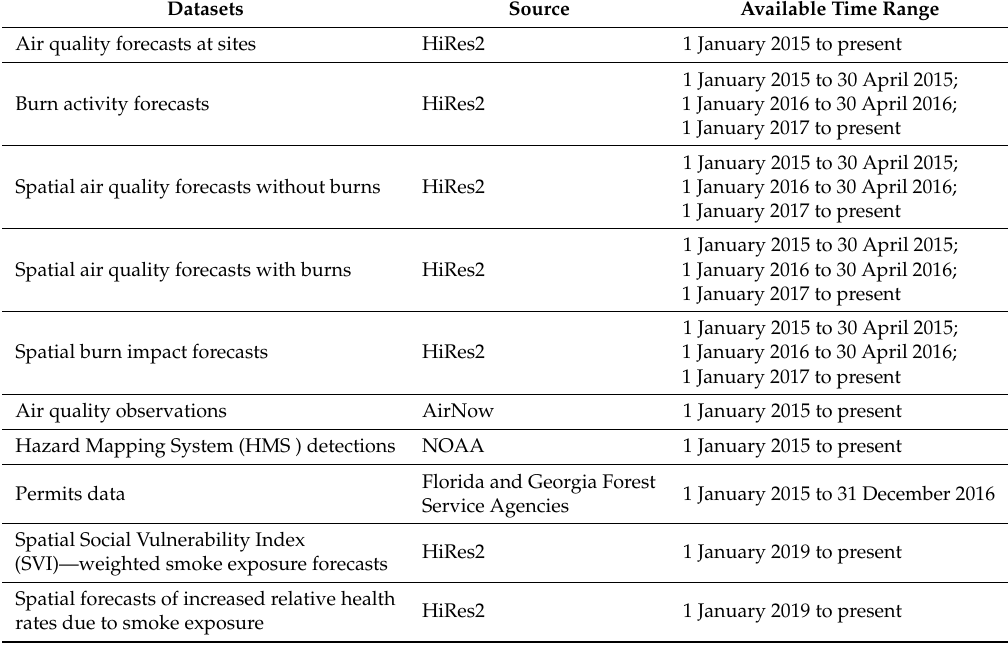
Table 1. Archived datasets and their available time